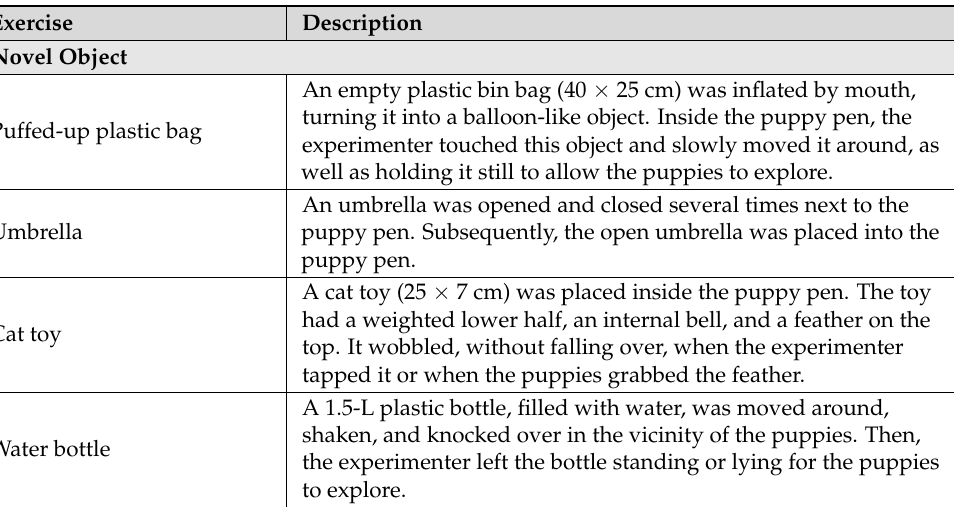
Table 2. Detailed descriptions of the